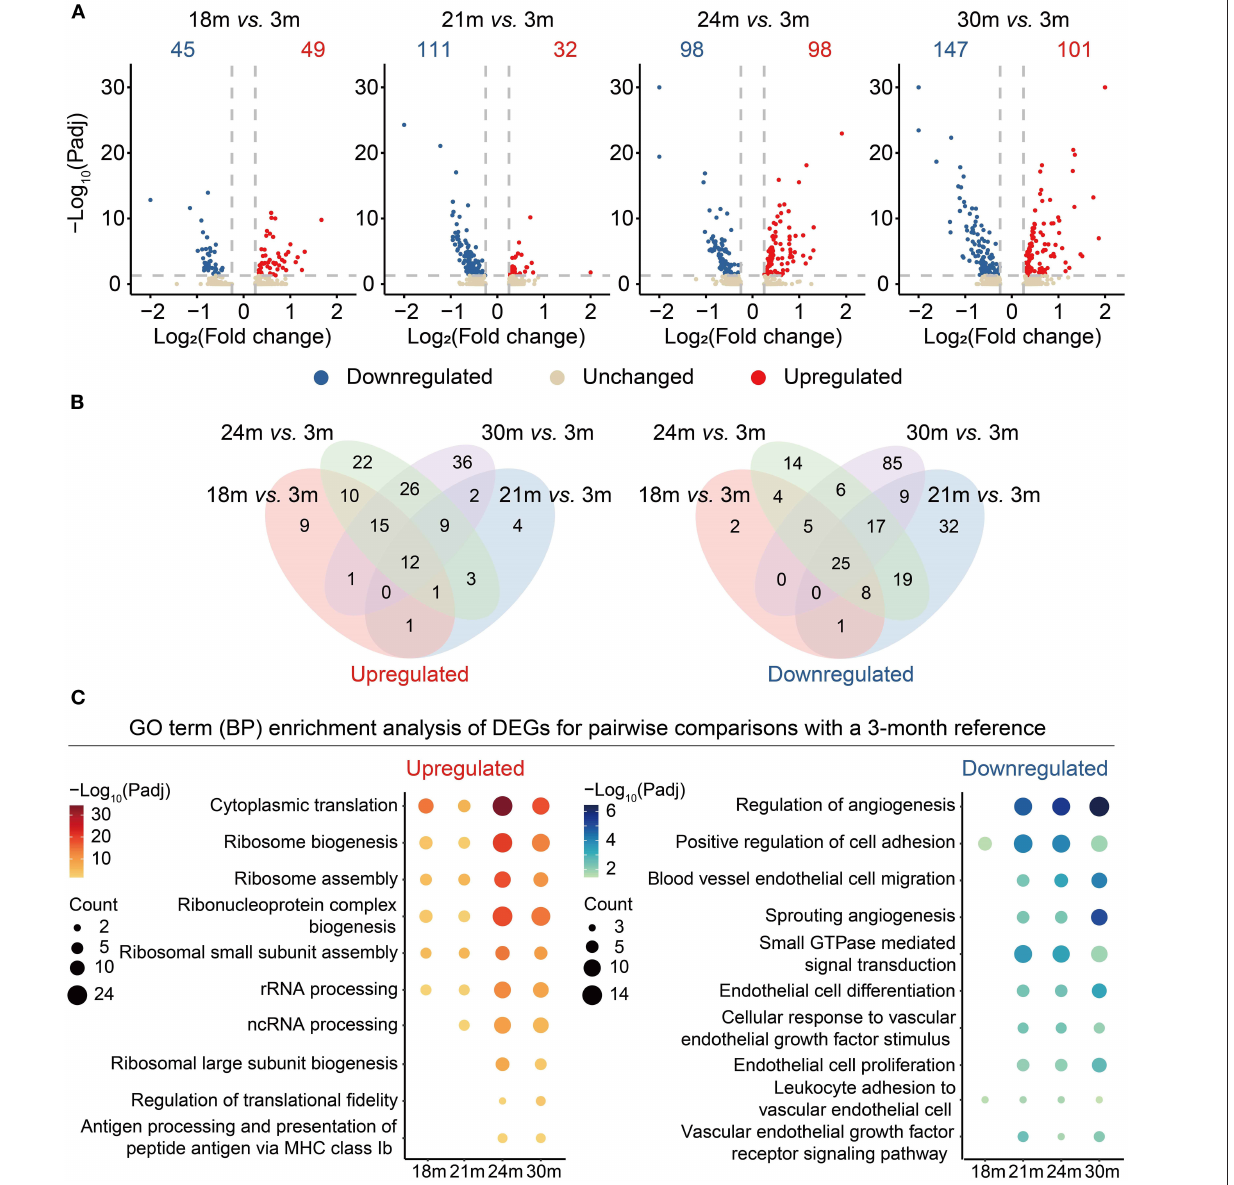
FIGURE 2 | Differential gene expression analysis of cardiovascular ECs across the lifespan. (A) Volcano plots showing differentially expressed genes (DEGs) between 18 and 3m, 21 and 3m, 24 and 3m, 30 and 3m (from left to right), respectively. X-axis indicates the Log 2 (fold change); Y-axis indicates the –Log 10 (adjusted p -values). Upregulated genes are colored in red and downregulated genes are colored in blue. (B) Venn diagrams showing the numbers of overlapped upregulated (left) and downregulated (right) DEGs between four comparisons, including 18 vs. 3m (red), 21 vs. 3m (blue), 24 vs. 3m (green), 30 vs. 3m (purple). (C) Dot plots showing representative GO terms enriched in DEGs based on functional enrichment analysis. –Log 10 (adjusted p -values) are indicated by colors, and gene counts of each GO term are indicated by the dot